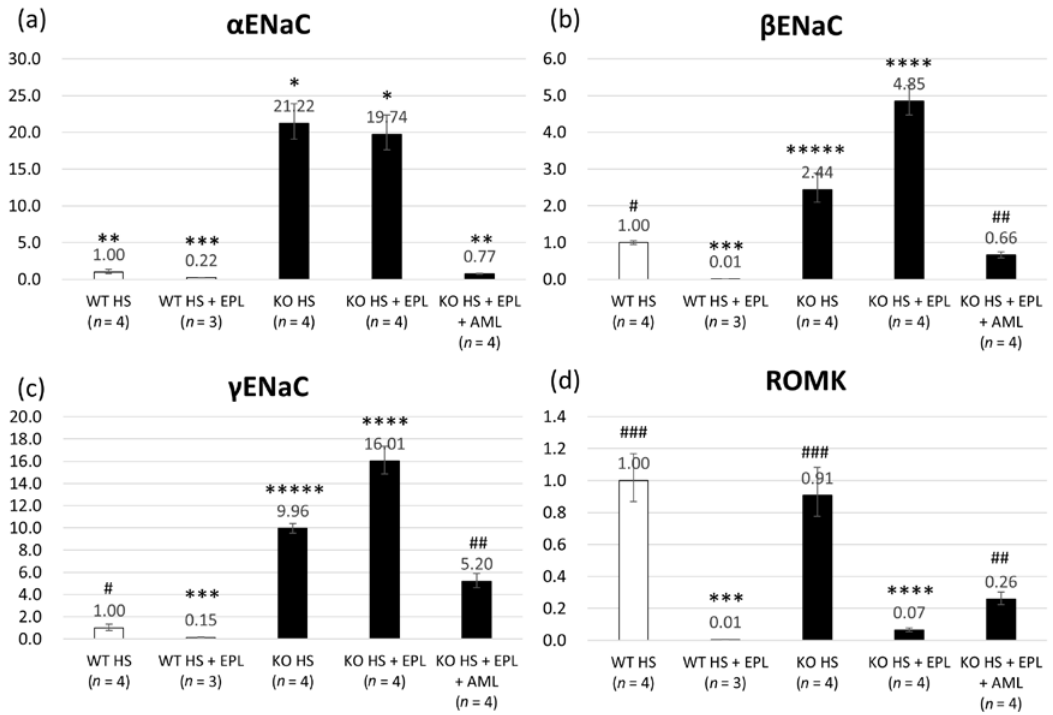
Figure 4. Total RNA abundance of ( a ) α ENaC ; ( b ) β ENaC ; ( c ) γ ENaC ; and ( d ) ROMK in laser-captured distal tubules/connecting tubules/cortical collecting ducts analyzed by one-way ANOVA. Data